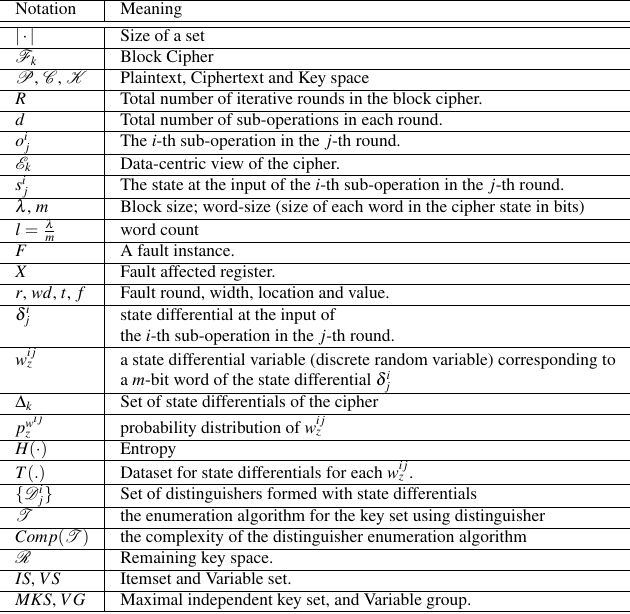
Table 1: List of Notations